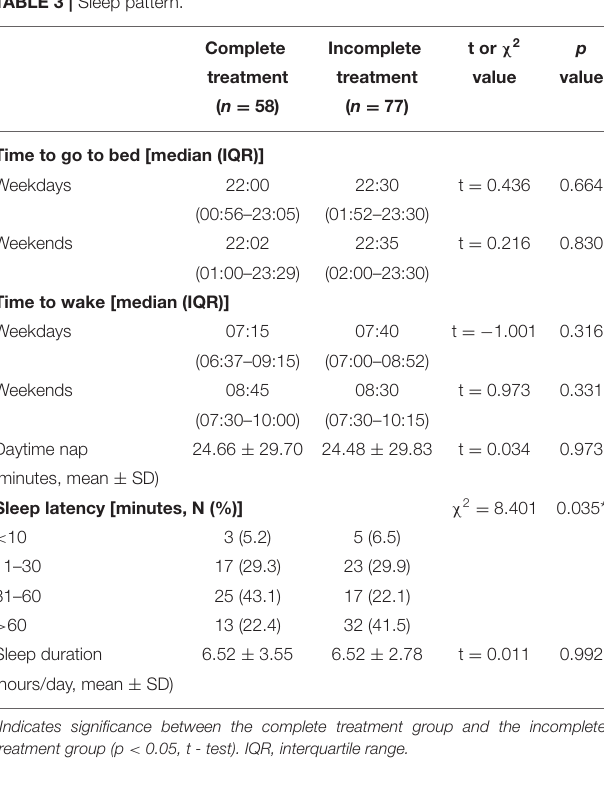
decreased in both groups during follow up compared to their baseline values, with a greater magnitude of decrease in the complete treatment group ( Figure 3